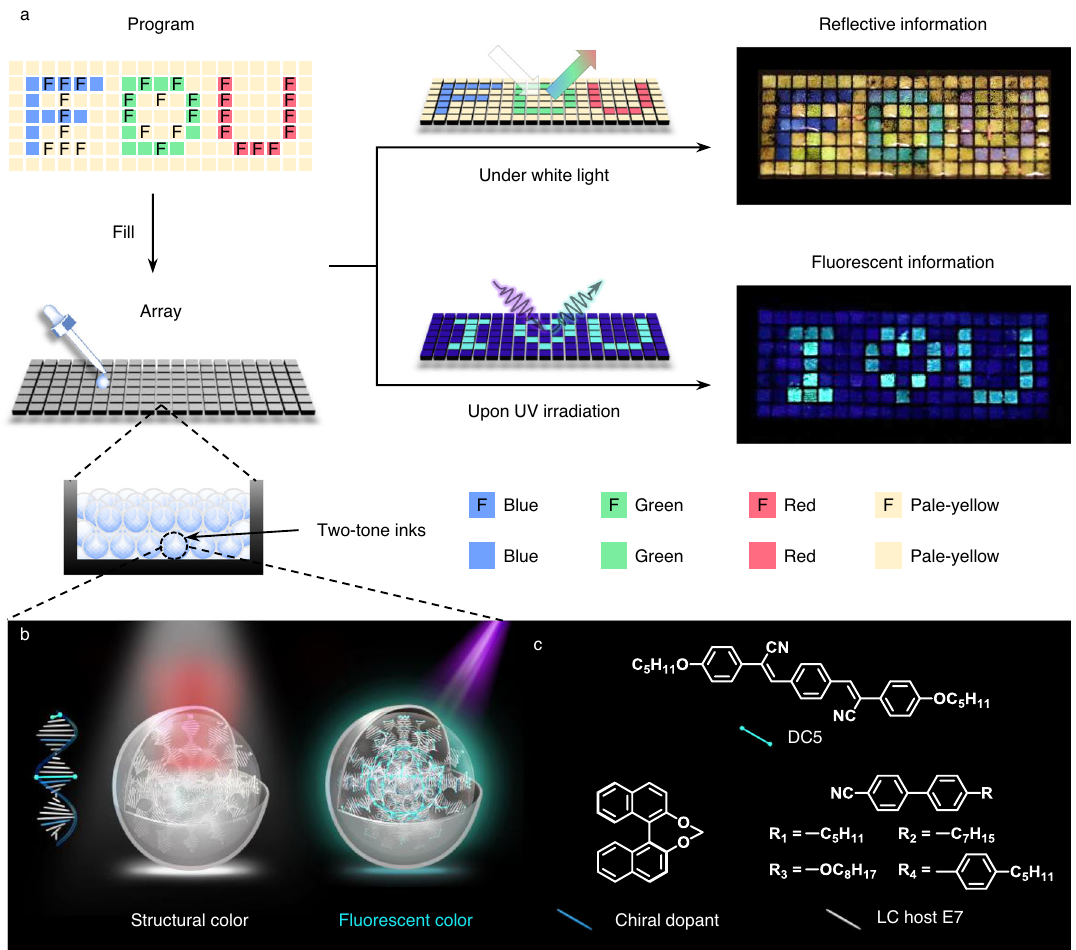
Fig. 1 Design of geminate labels programmed by two-tone microdroplets. a Schematic illustration to show the design of a geminate label created by using two-tone inks and photographs of the resulting label (47 mm × 17 mm) in re fl ective and fl uorescent states. The label carrying two distinct kinds of information demonstrates a re fl ective pattern of RGB “ FDU ” under white light and a fl uorescent pattern of cyan “ I love U ” upon UV irradiation. The blue, green, red, and pale-yellow colors of the blocks represent the re fl ection colors of the microdroplets and letter “ F ” represents the microdroplets with fl uorescence. b Schematic illustration to show fl uorescent cholesteric liquid crystal (FCLC) microdroplets (two-tone inks) combining structural color under white light and fl uorescent color upon UV irradiation. c Chemical structures of the materials used to prepare the FCLC mixtures, including fl uorescent molecule DC5, (S)-binaphthyl derivative chiral dopant and LC host